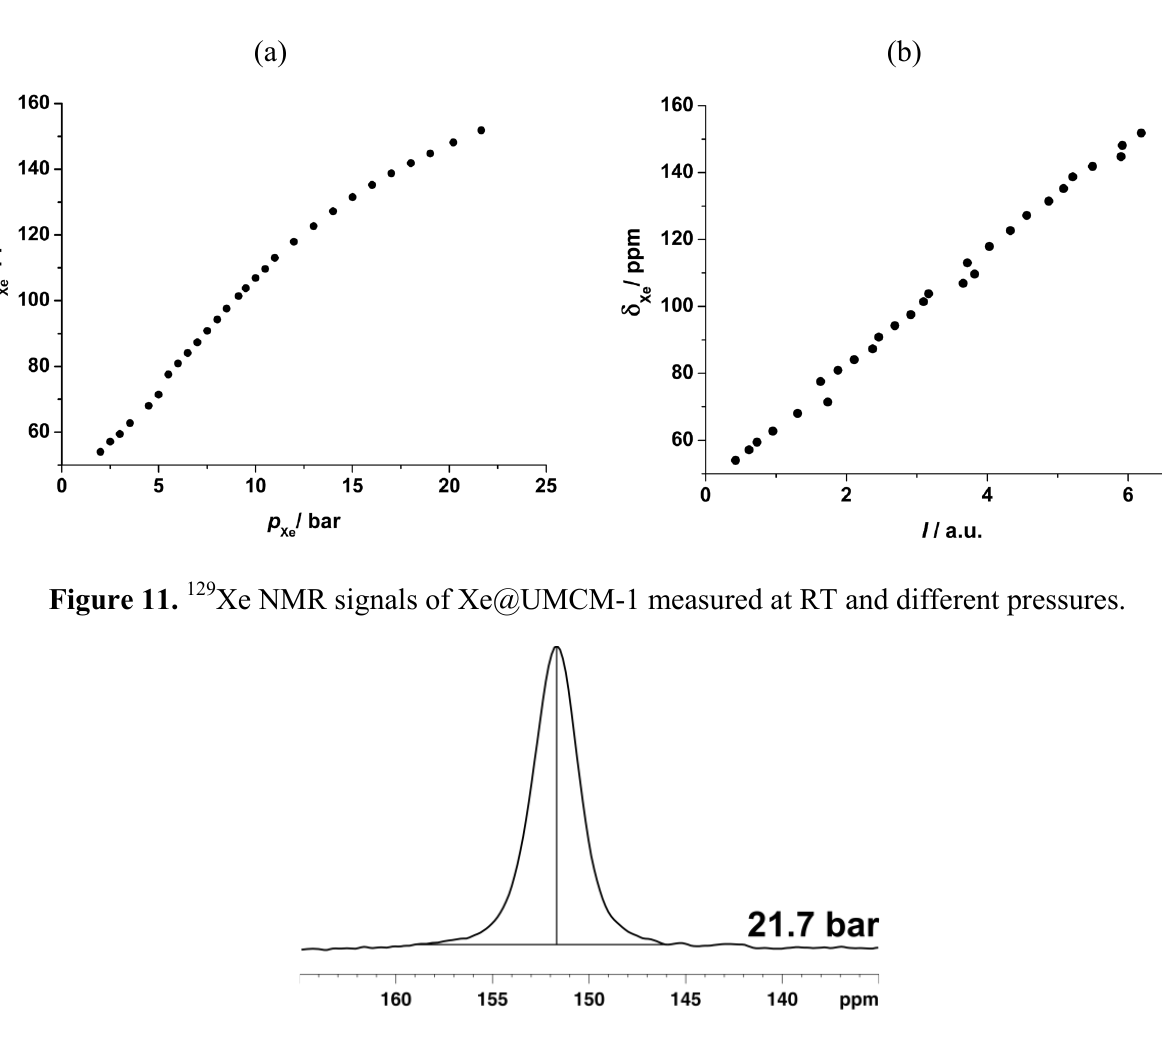
Figure 10. 129 Xe NMR chemical shift of xenon adsorbed on UMCM-1 (see Figure 9) measured at RT as a function of pressure ( a ) and xenon signal intensity ( b ).